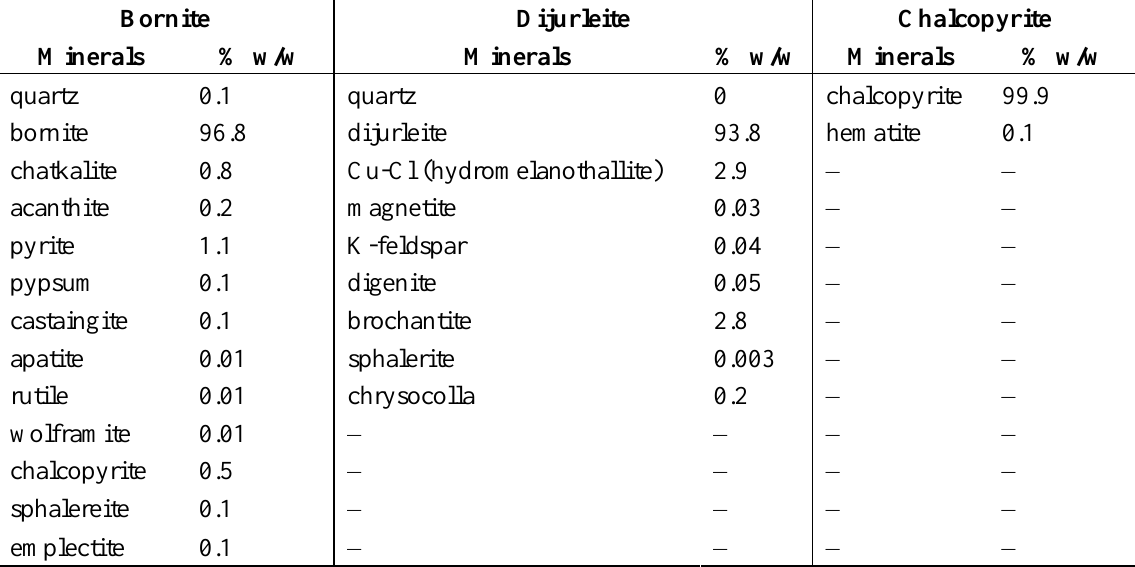
Table 2. Mineralogical compositions of copper sulphide